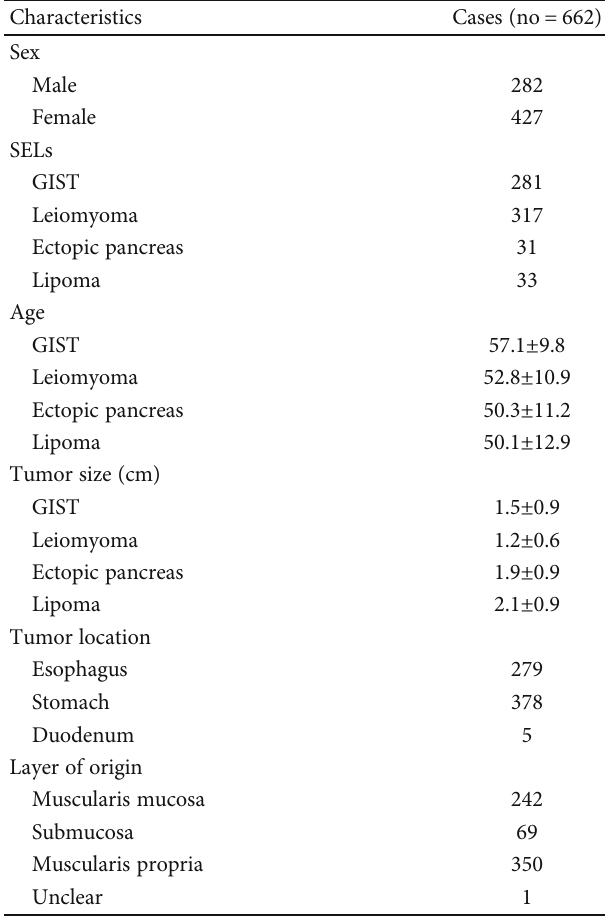
Table 1: Clinical characteristics of patients with